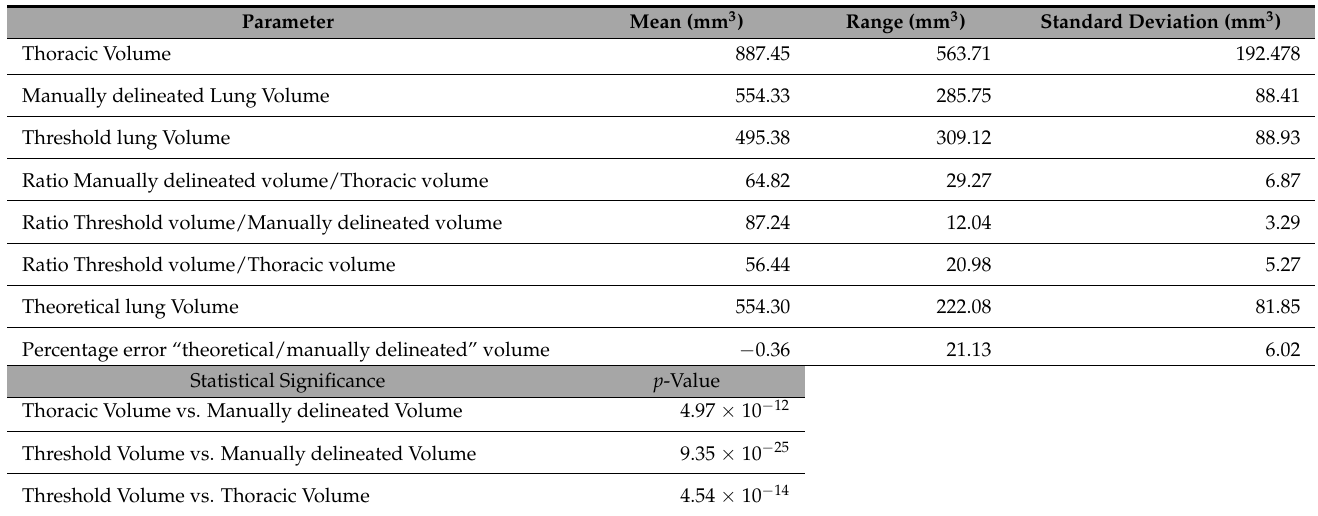
Table A2. Statistical results of healthy